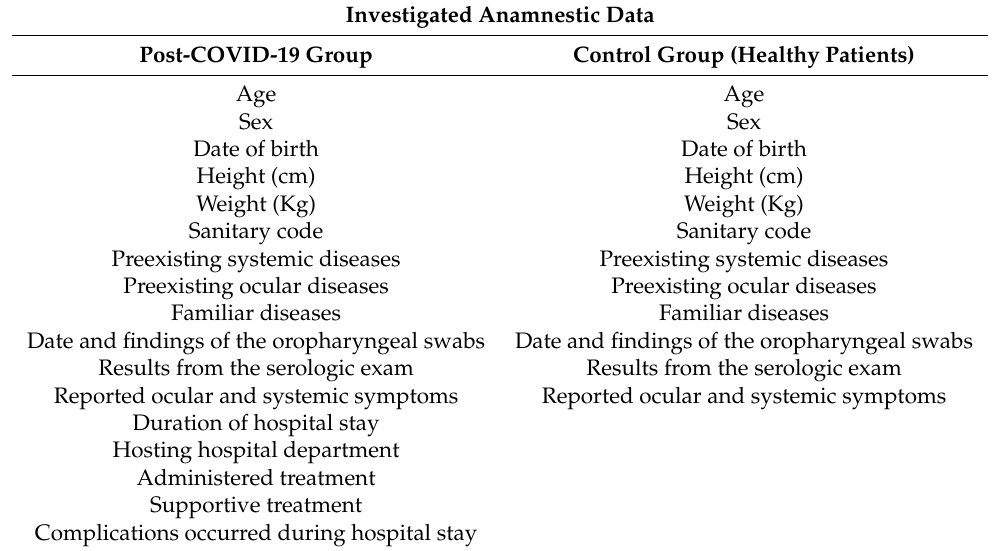
Table 1. Demographic and anamnestic data were collected by the same physician performing the visit.